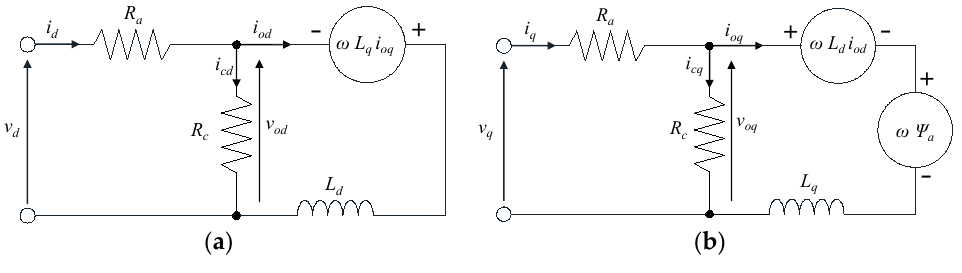
Figure 14. Equivalent circuit: ( a ) d axis, and ( b ) q axis.